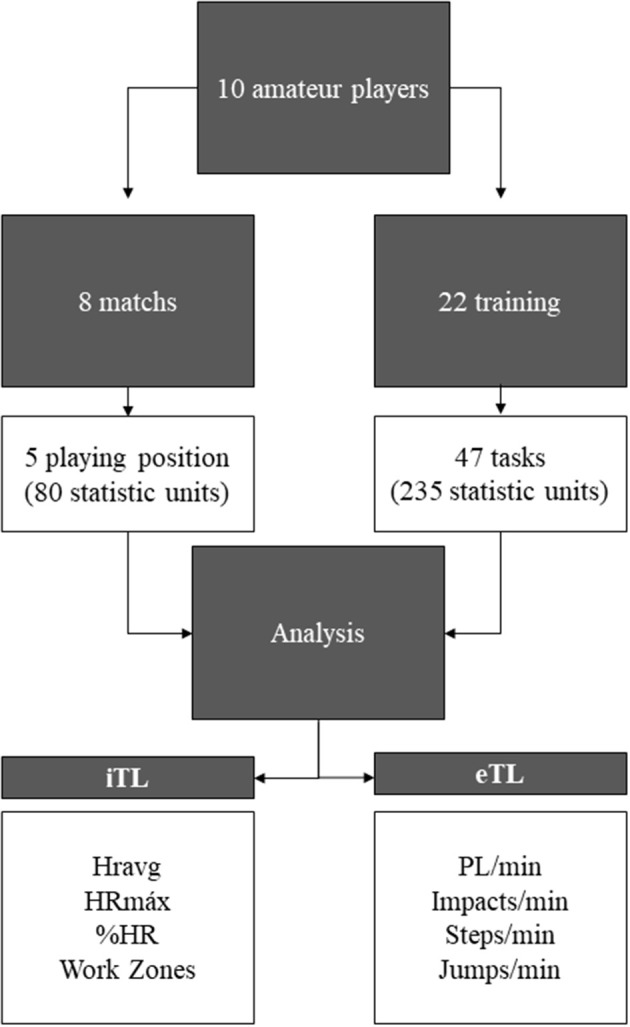
Methods flow chart.